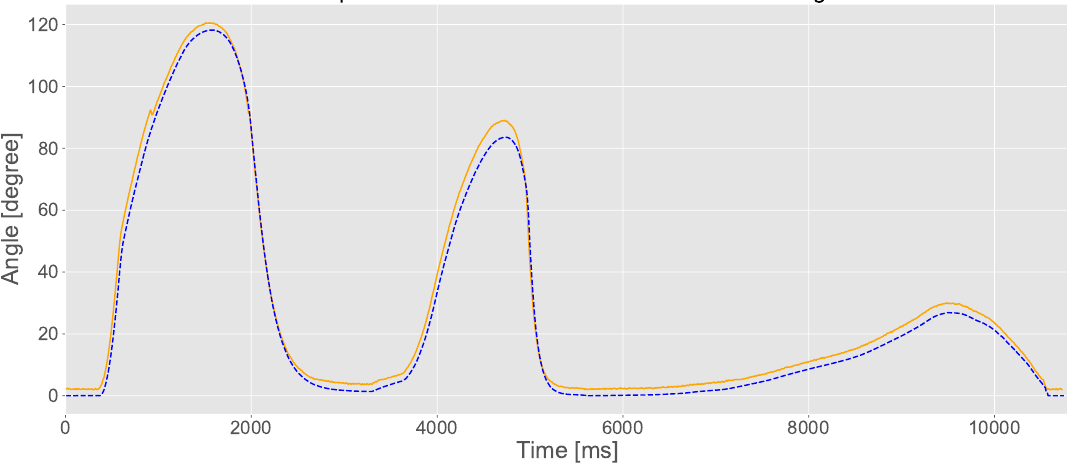
Figure 9. Graph of the trajectory of the elbow joint test. The solid blue line is the values read by the gyroscope, and the dashed orange line is the value computed by the control